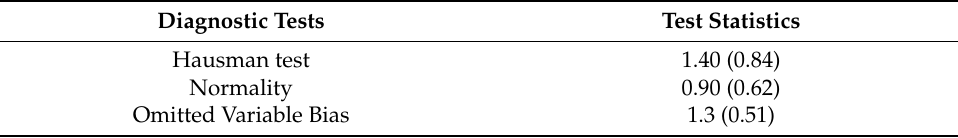
Table 9. Results of diagnostic tests of the panel ARDL